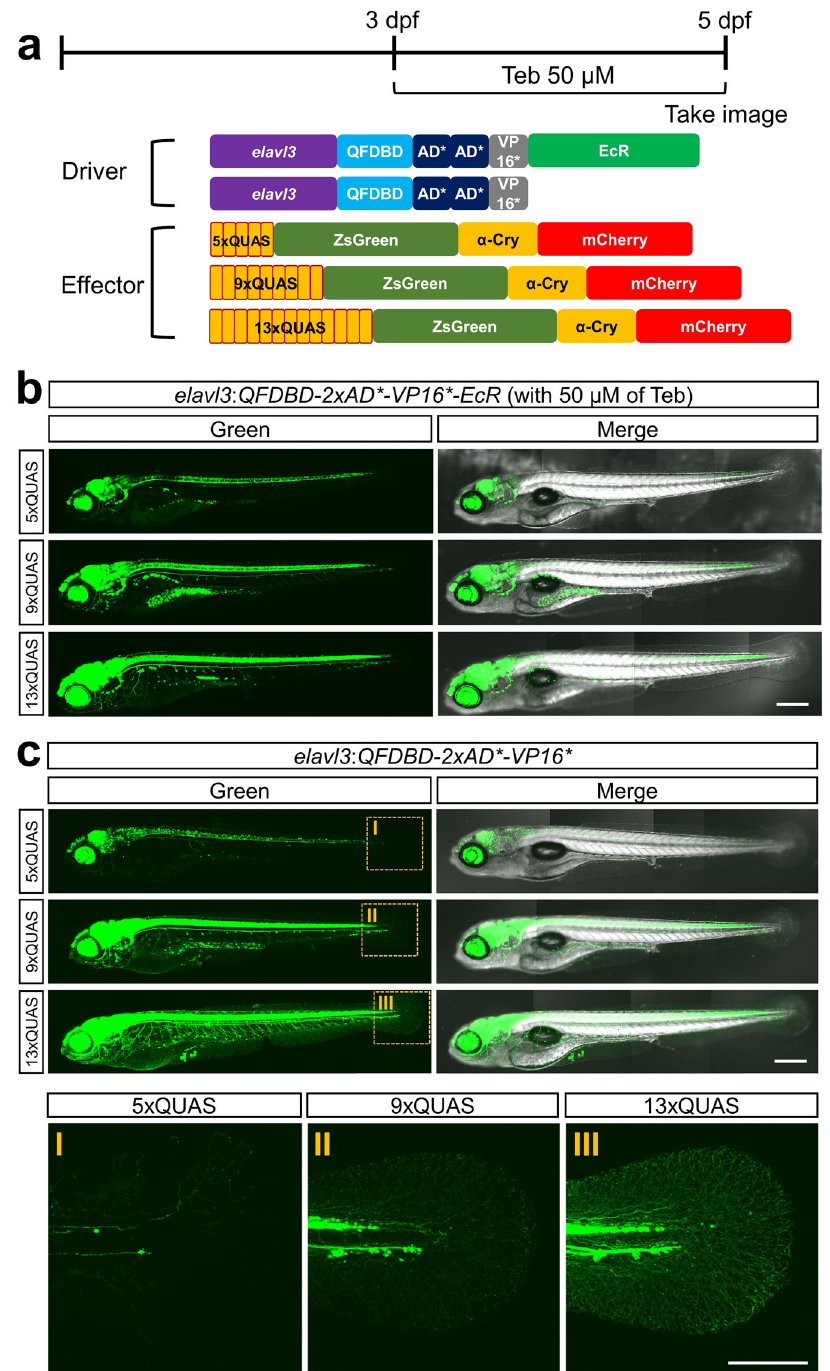
Fig. 5 Tissue-speci fi c activation of IQ-Switch can be attained by using a discrete cell-type-speci fi c promoter. a Schematic illustration of a driver under the control of elavl3 promoter and respective effectors harboring different numbers of QUAS. The driver constructs were equipped with 8.7 kb of elavl3 promoter instead of ubb promoter. Teb (50 µ M) was administered for 48 h before imaging at 5 dpf. b Genetic cross of F1 Tg ( elavl3:QFDBD-2xAD*-VP16- EcR ) with indicated F2 effector lines. The siblings were exposed to Teb to induce ZsGreen transgene expression. Note that the intensity of ZsGreen reporter fl uorescence in the pan-neuronal tissues driven by elavl3 promoter was gradually augmented in the order of the increased number of QUAS repeats. c Genetic cross of F1 Tg ( elavl3:QFDBD-2xAD*-VP16* ) with indicated F2 effector lines. The intensity of ZsGreen fl uorescence among the siblings was most prominent with an effector harboring a 13xQUAS transgene. Abbreviations: Teb; tebufenozide. Scale bar: 200 μ